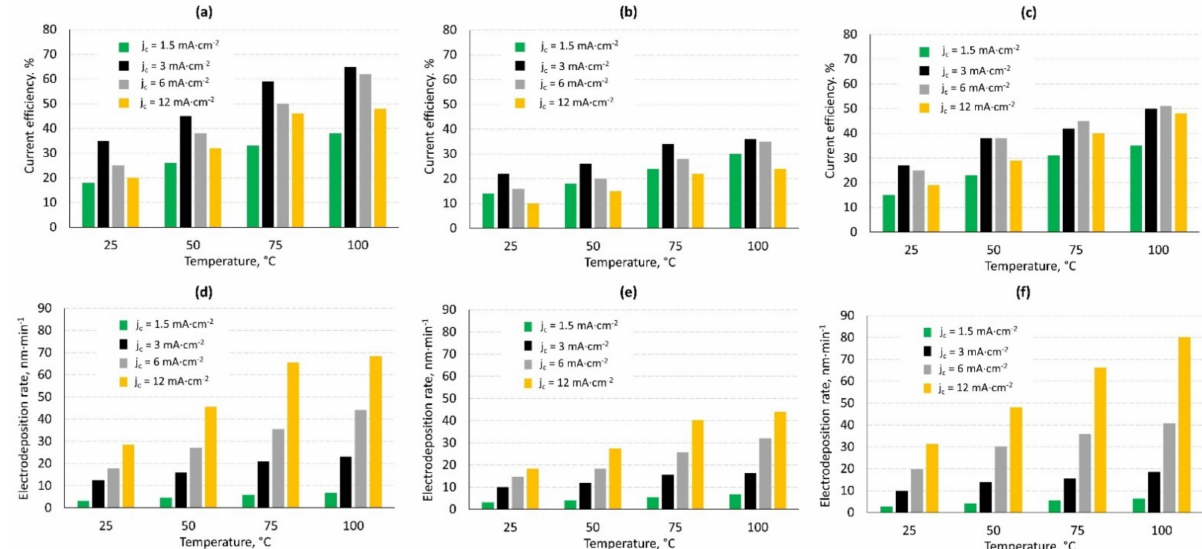
Figure 12. The effect of cathodic current density and temperature on the current efficiency ( a – c ) and electrodeposition rate ( d – f ) of copper from Cu-60 bath ( a , d ), zinc from Zn-800 bath ( b , e ) and CuZn alloy coatings from CuZn-3 bath ( c , f